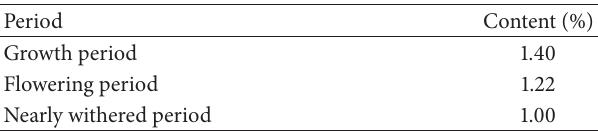
Table 1: Content of essential oil of T. quinquecostatus in different